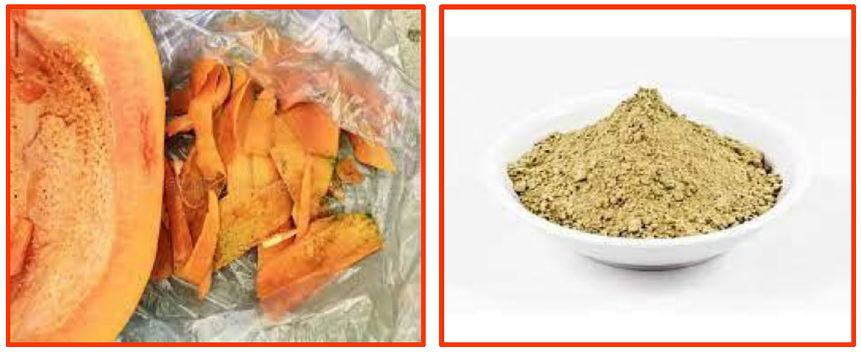
Figure 1. Carica shell